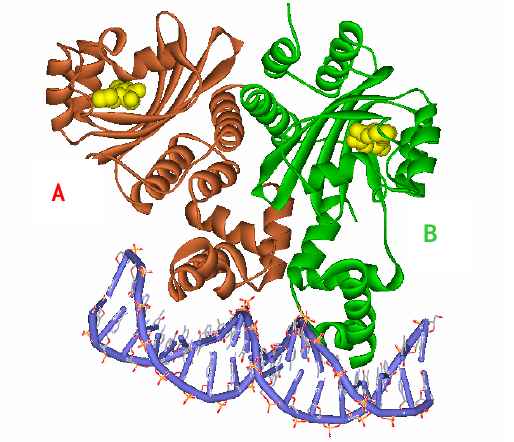
Figure 3: Ribbon diagram of the two subunits, A (red) and B (green), complexed with the autoinducer (yellow) of the asymmetric unit.